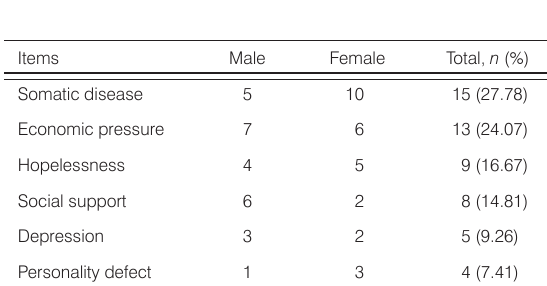
Table 3. Relevant causes associated with